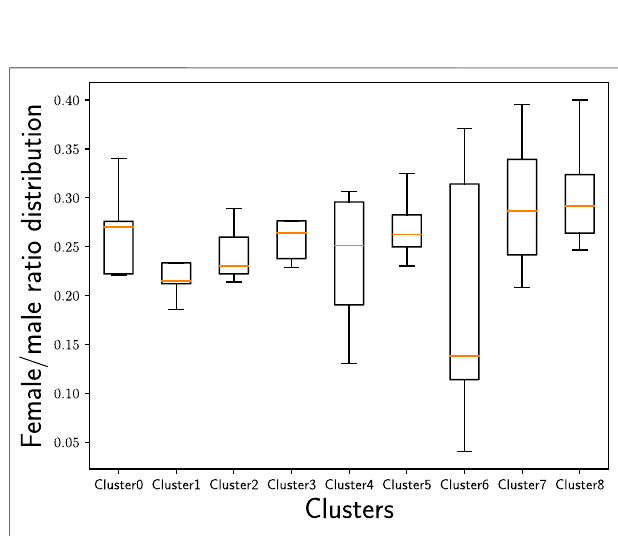
FIGURE 11 | Distribution of users ’ average playcount in the identi fi ed country clusters. While the highest average playcount can be found in Cluster 2, the lowest one can be found in Cluster 6.